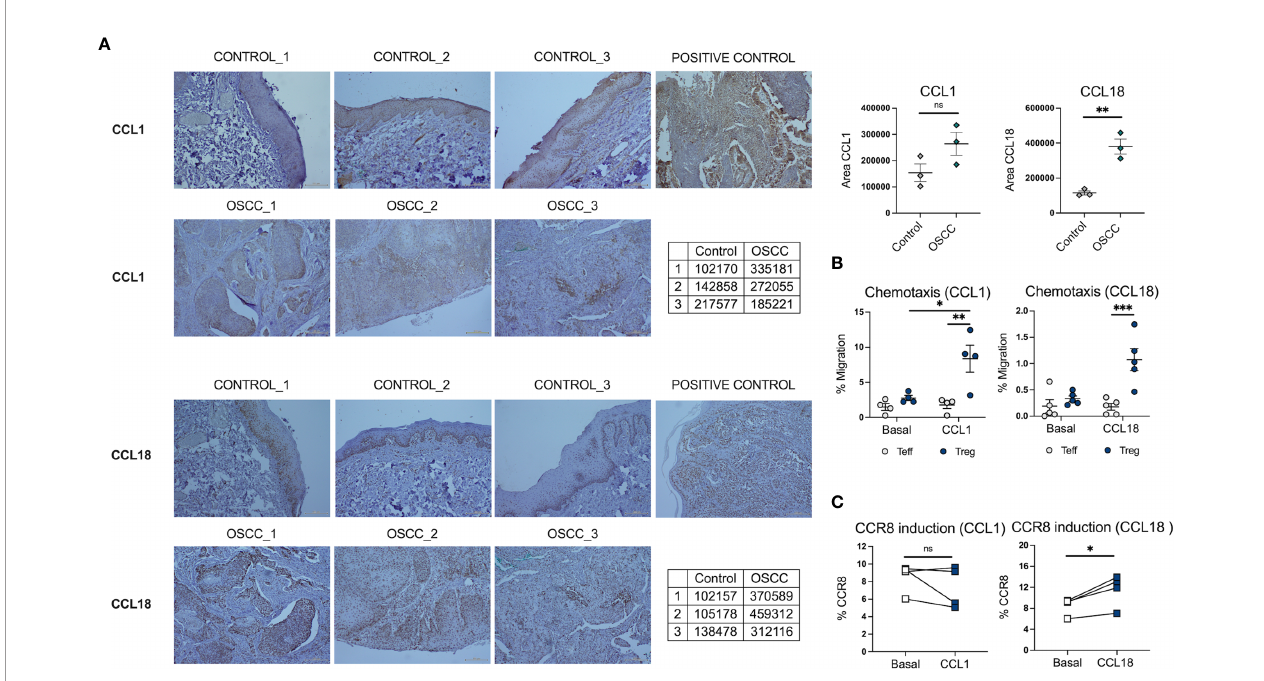
FIGURE 8 | CCL18 is augmented in histological samples of OSCC patients and also induce CCR8 expression in Teff. (A) Representative histological staining of CCL1 and CCL18 in a biopsy from a patient with OSCC and a patient without malignancy, using colon carcinoma as a positive control for CCL1 and melanoma as a positive control for CCL18. (B) Semi-quanti fi cation of area for CCL1 and CCL18 staining by ImageJ, data is presented as mean ± SEM using individual values described in the tables (Unpaired t test). (C) Percentage of migrated memory Teffs and Tregs to recombinant chemokines CCL1 and CCL18. Sorted Cell trace violet + Memory Teffs (5×10 4 ) and unstained memory Tregs (5×10 4 ) were placed in the top chamber of a 5- m m-pore Transwell fi lter system. Bottom chambers were fi lled with media only, CCL1 or CCL18, (all 0.5 ug/mL). The percentage of migration for each subset was calculated as (number of cells in the bottom chamber after 1 h × 100)/initial number of cells in the top chamber. Data are presented as mean ± SEM using scatter dot plots (Paired t test). (C) CCR8 expression was measured in pre-activated memory Teffs (1x10 5 ) cultured with media only, or media with CCL1 or CCL18, (all 0.5 ug/mL) for 72h, data are presented using individual symbols with paired lines (Paired t test). For all statistical tests, ∗∗∗ p < 0.001, ∗∗ p < 0.01 and ∗ p < 0.05 were considered signi fi cant. ns, not signi fi